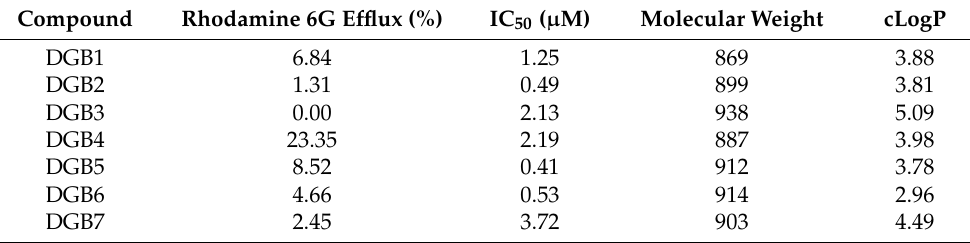
Table 2. Results of rhodamine 6G accumulation and ATPase activity assays, and physicochemical properties of digoxin derivatives. The assays were performed three times on different